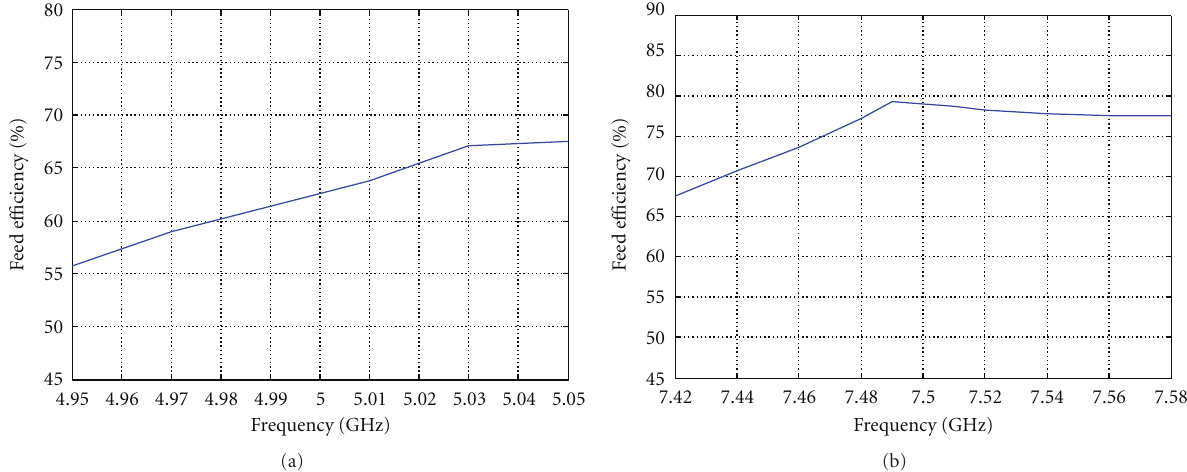
Figure 24: Feed e ffi ciency comparison for the lower (a) and higher (b) frequency band.